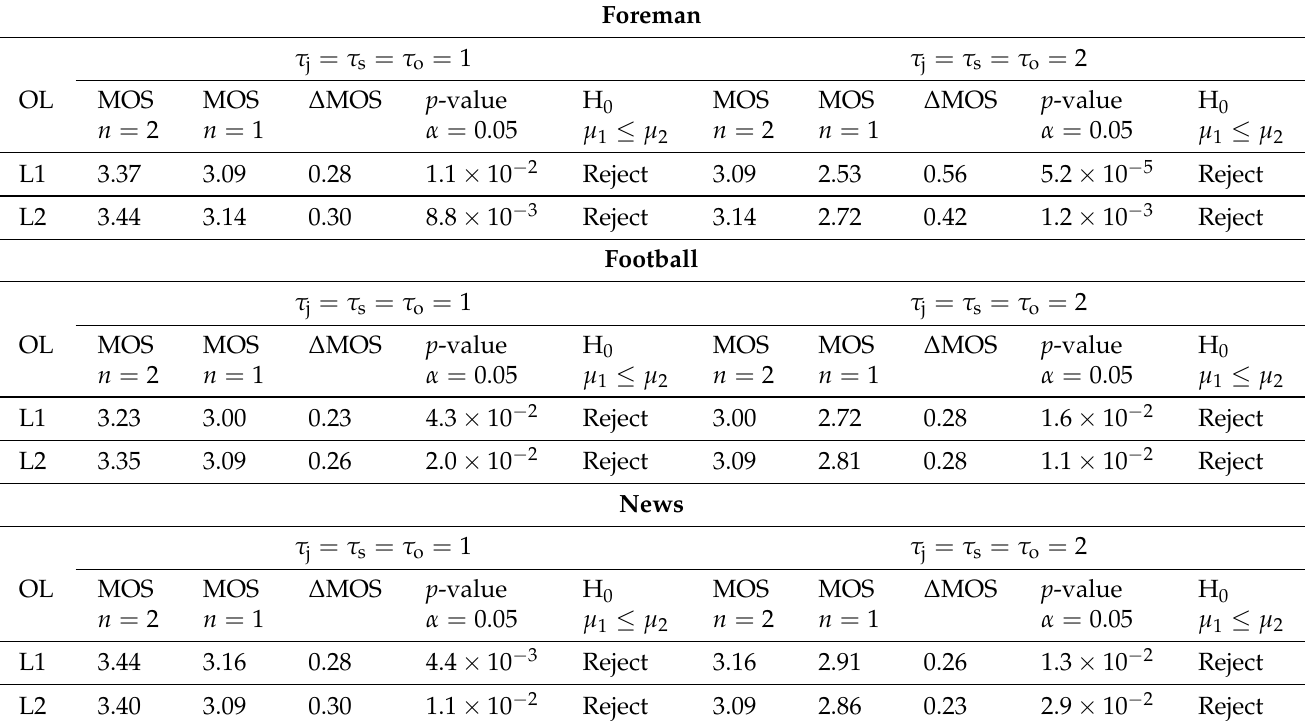
Table 6. Analysis of the impact of the capacity factor n on the MOS Gain using Student’s t -test.